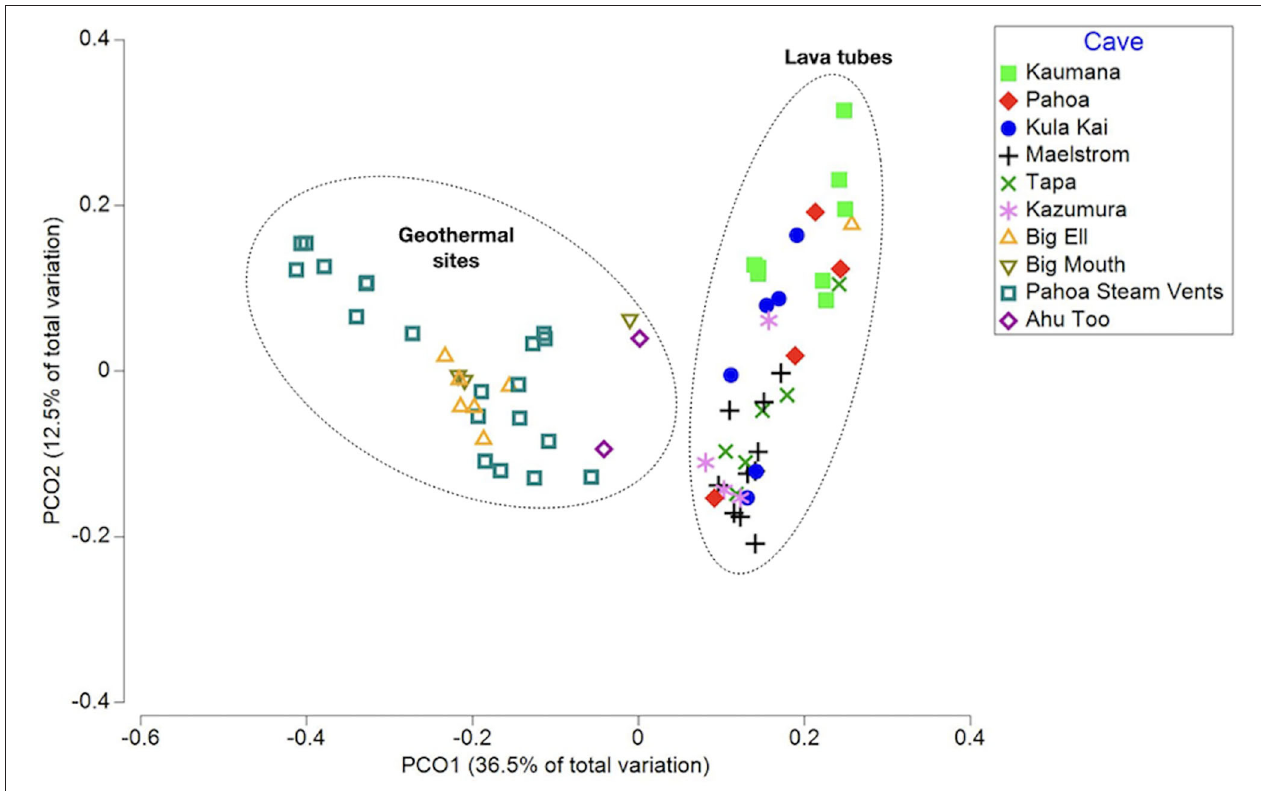
FIGURE 1 | A principal coordinates analysis (PCoA) of the weighted Unifrac distance measured between samples, capturing 49% of the variation in multivariate space. Samples are displayed as the cave or site they were collected from. This illustrates that samples from geothermal sites and lava caves are two distinct populations in terms of phylogenetic community composition and